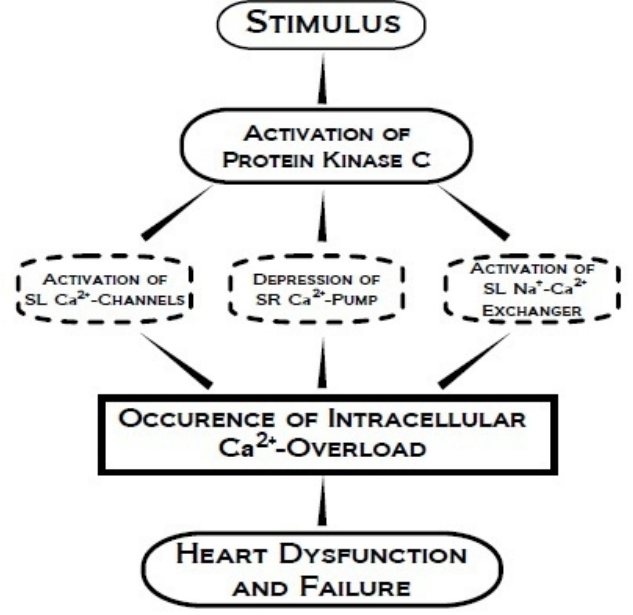
Figure 6. Schematic representation of the signal transduction pathway involving the activation of protein kinase C, occurrence of intracellular Ca 2+ overload and cardiac